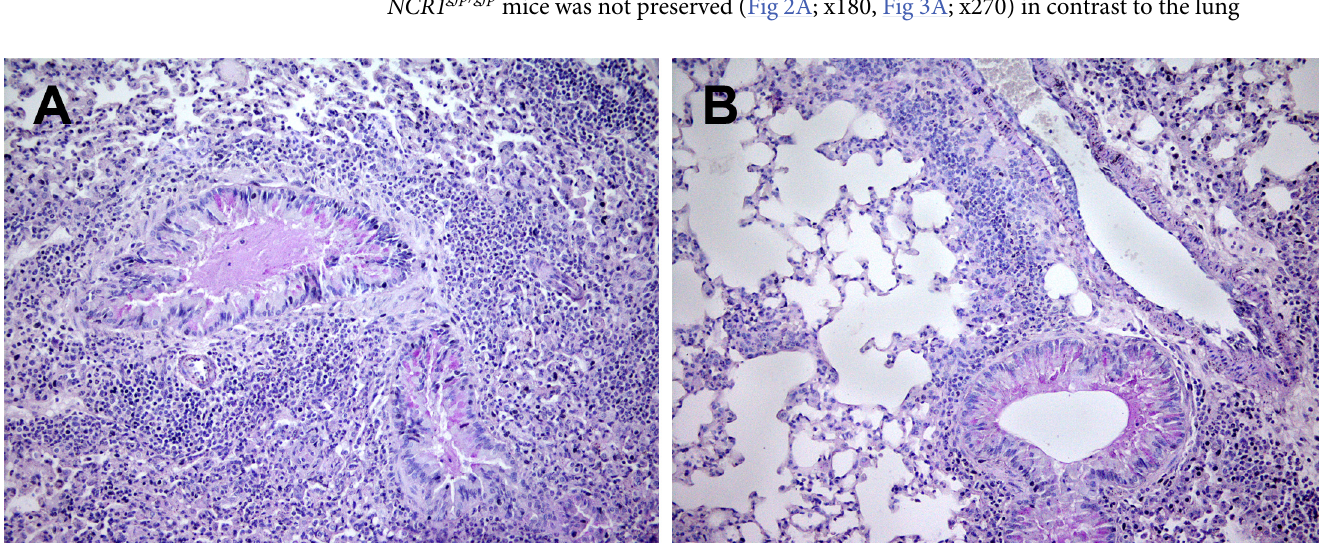
PLOS ONE | DOI:10.1371/journal.pone.0160779 August 31,